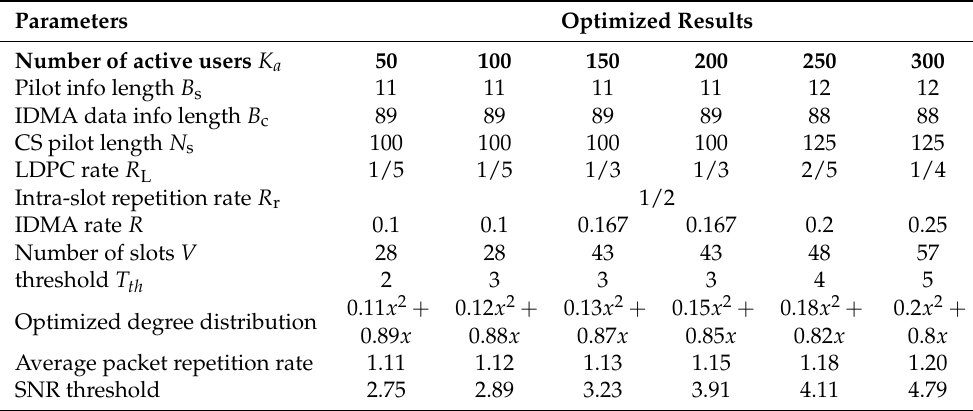
Table 2. Optimized coding parameters of the proposed scheme.